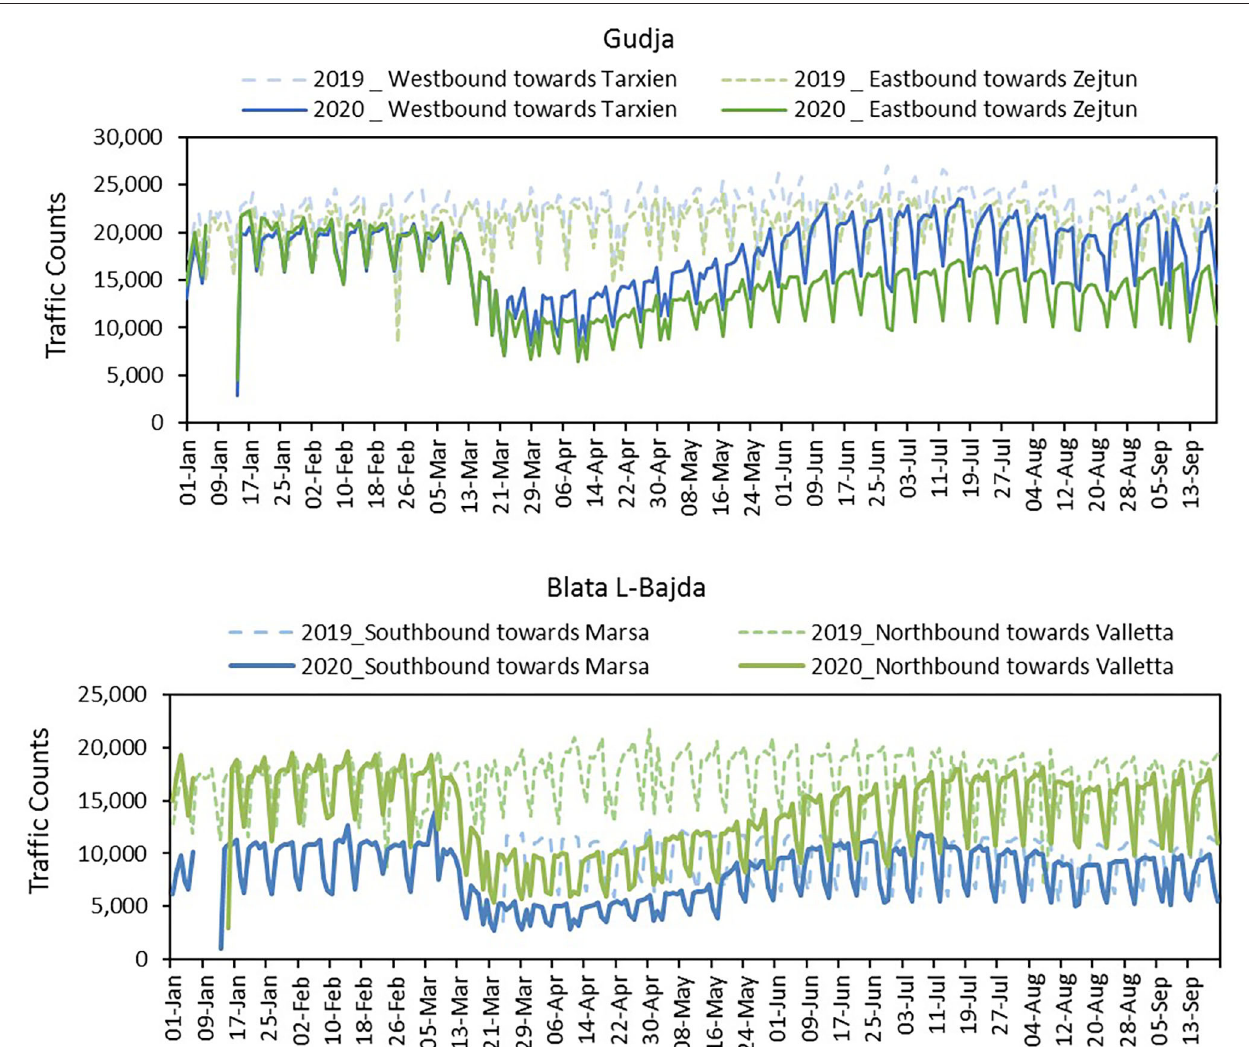
FIGURE 2 | Traffic counts measured by Transport Malta in (top panel) Gudja and (bottom panel) Blata L-Bajda between 1st January and 20th September 2019 (dashed lines) and 2020 (solid lines). Blue and green colors show different traffic directions.